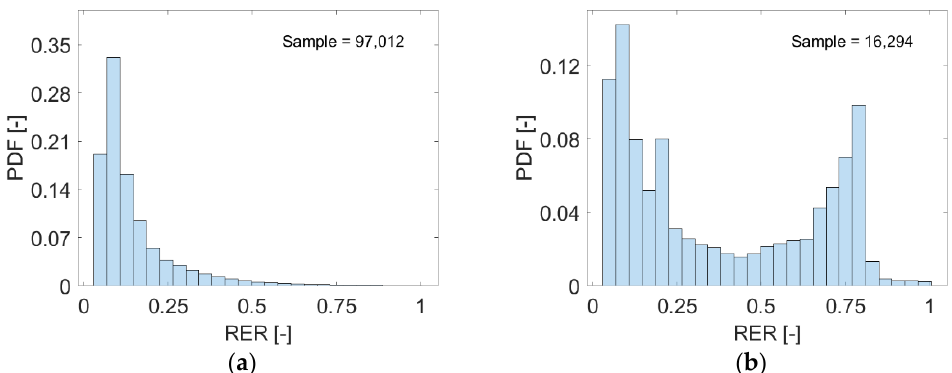
Figure 1. Probability density function (PDF) of RER in the energy certificates of Lombardy on the left ( a ) and Trentino on the right ( b ). Only certificates with RER greater than zero were analyzed.